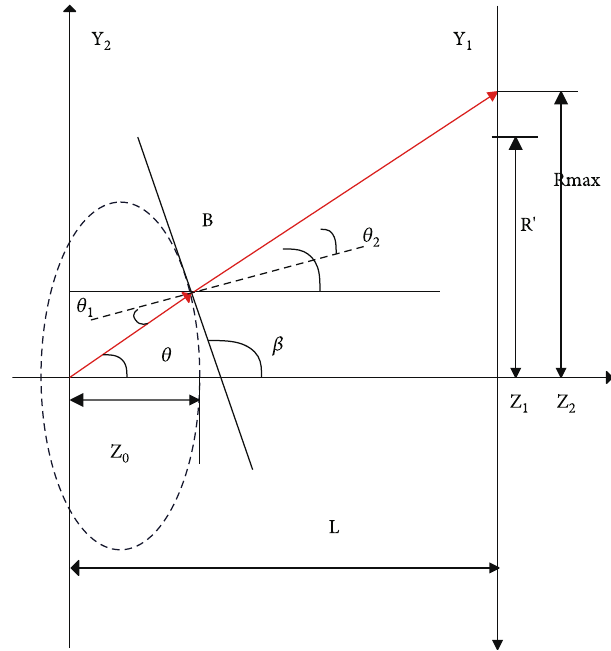
Figure 2: Light path diagram of LED lighting